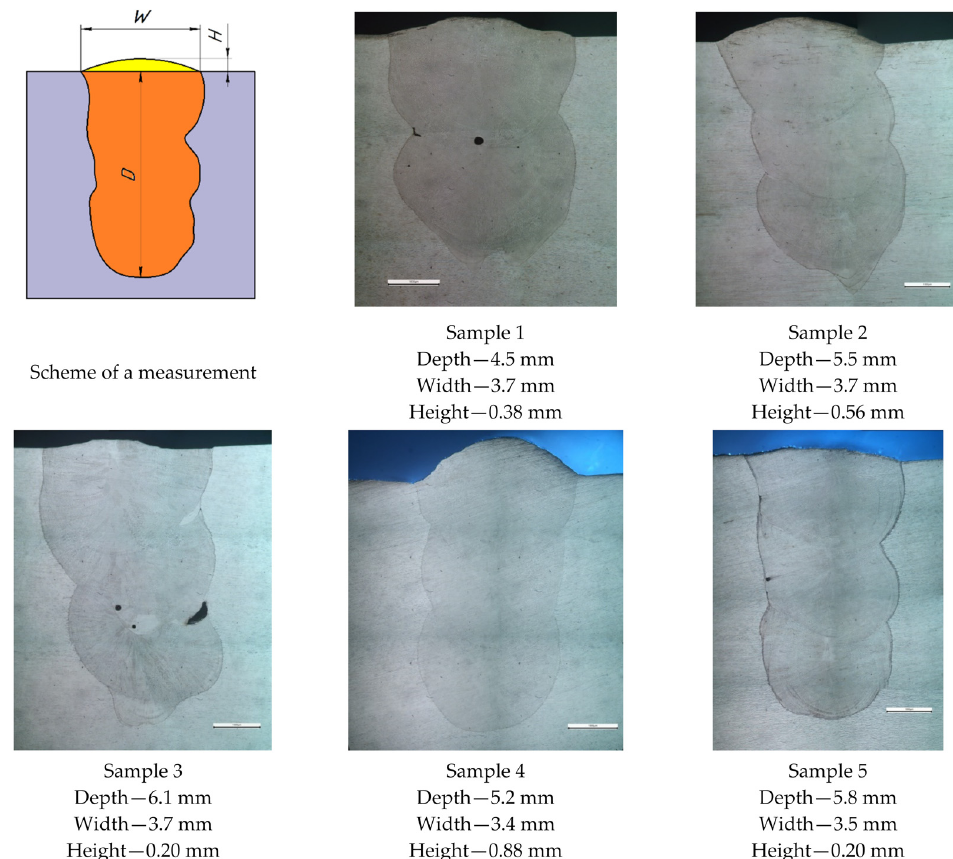
Figure 7. Macrostructure of multi-pass cladding samples obtained by mode 13.